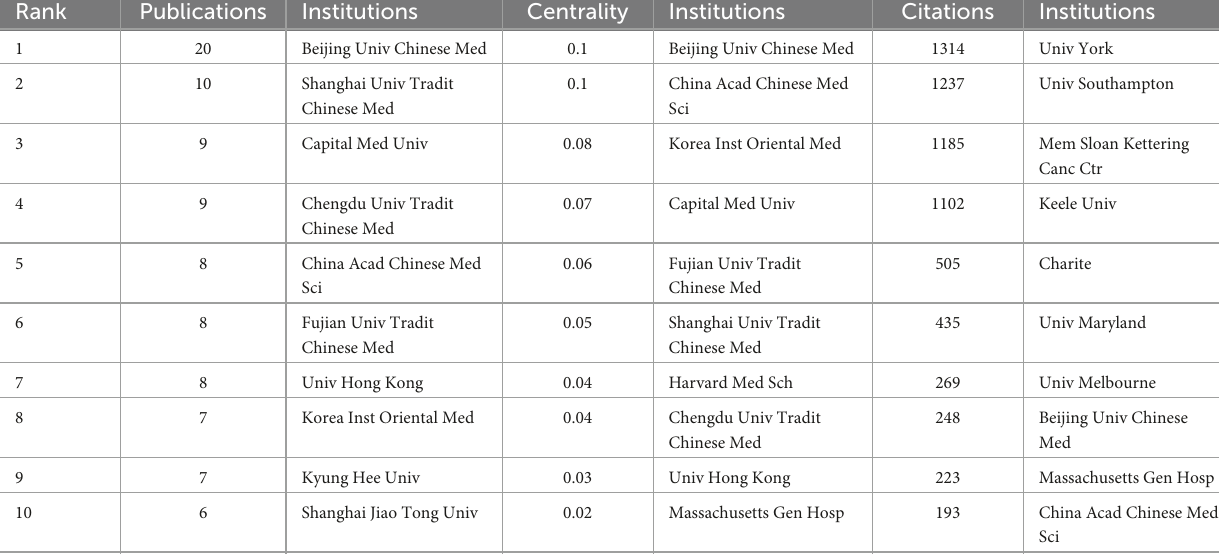
TABLE 4 Top 10 institutions related to Chinese non-pharmacological therapy on KOA. Rank